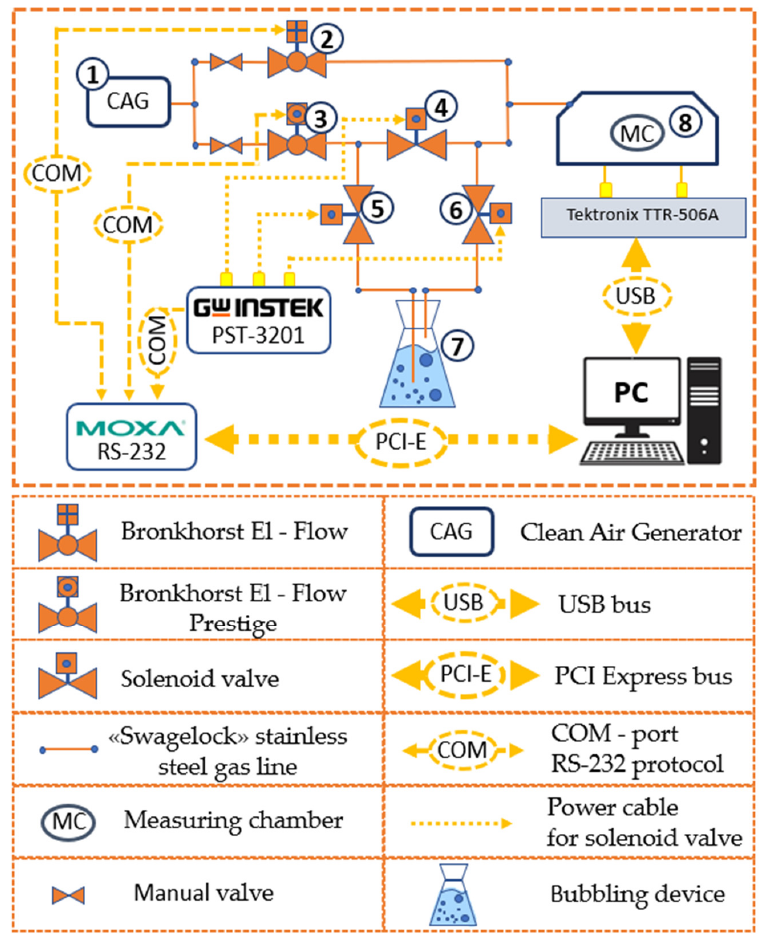
Figure 12. The scheme of an automated measuring setup.